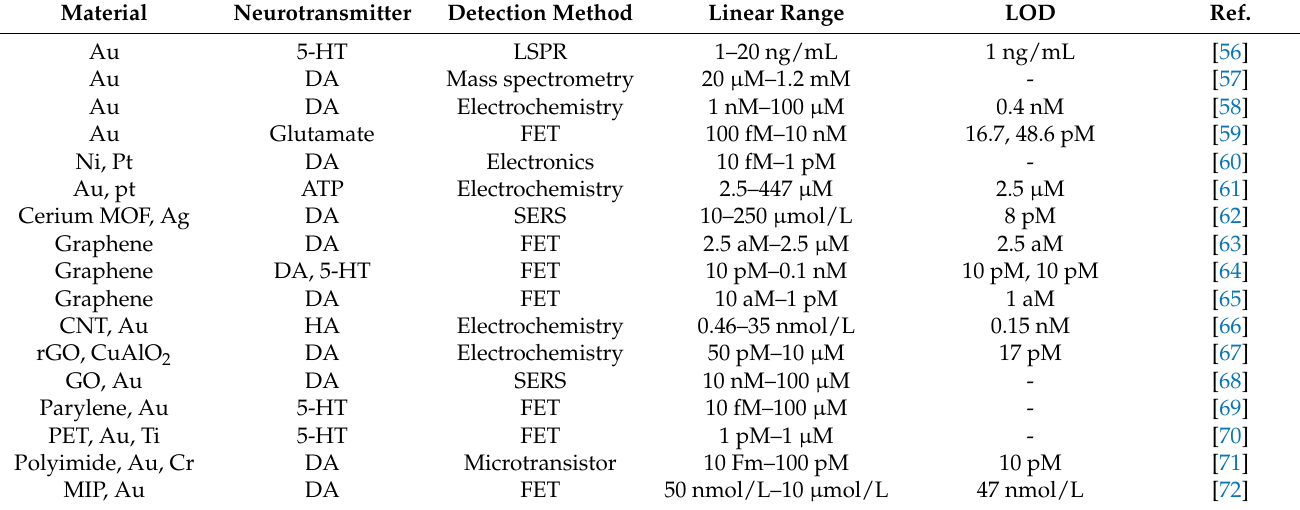
Table 1. Materials used to construct aptamer sensors for